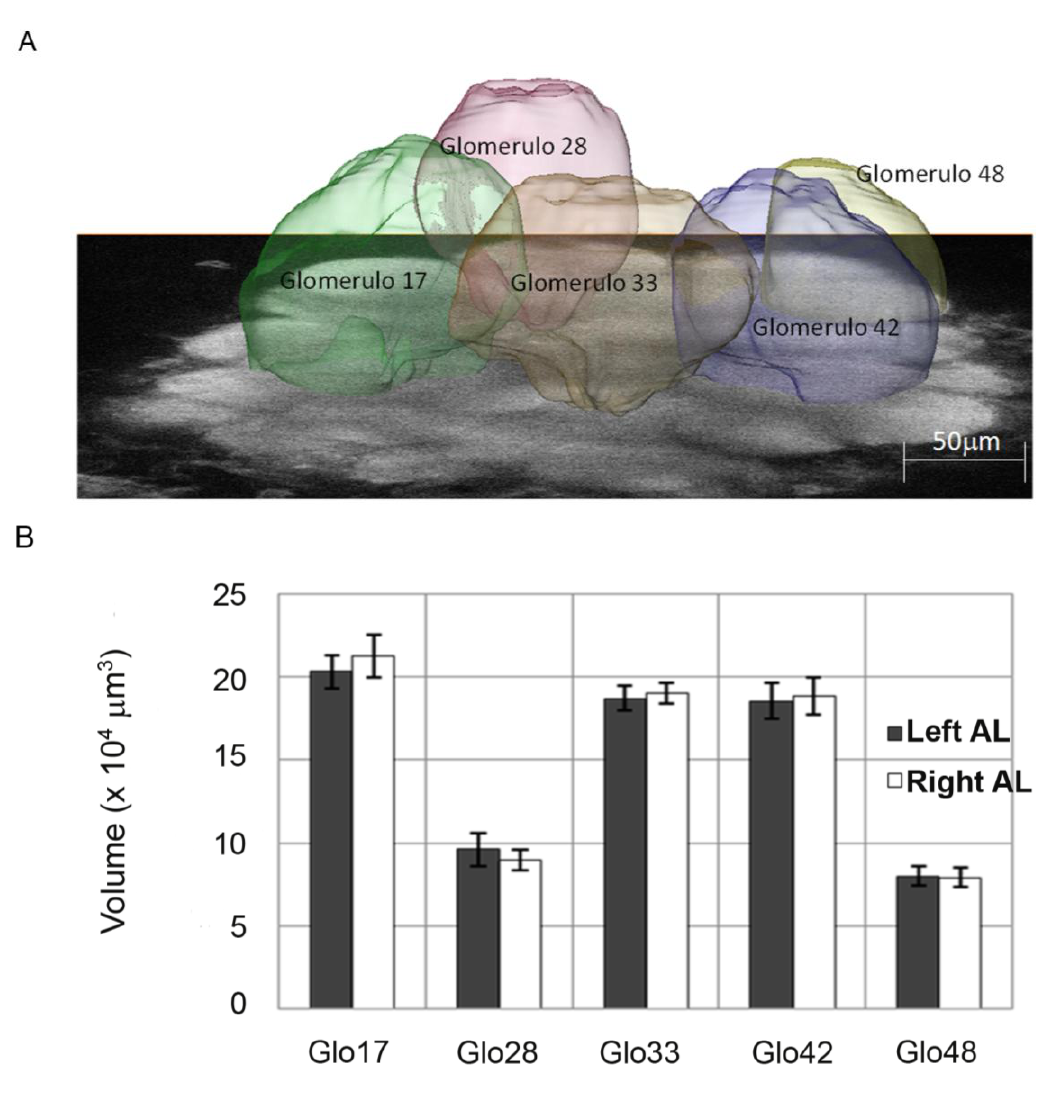
Figure 5. ( A ) Single image of the left antennal lobe of Apis mellifera acquired